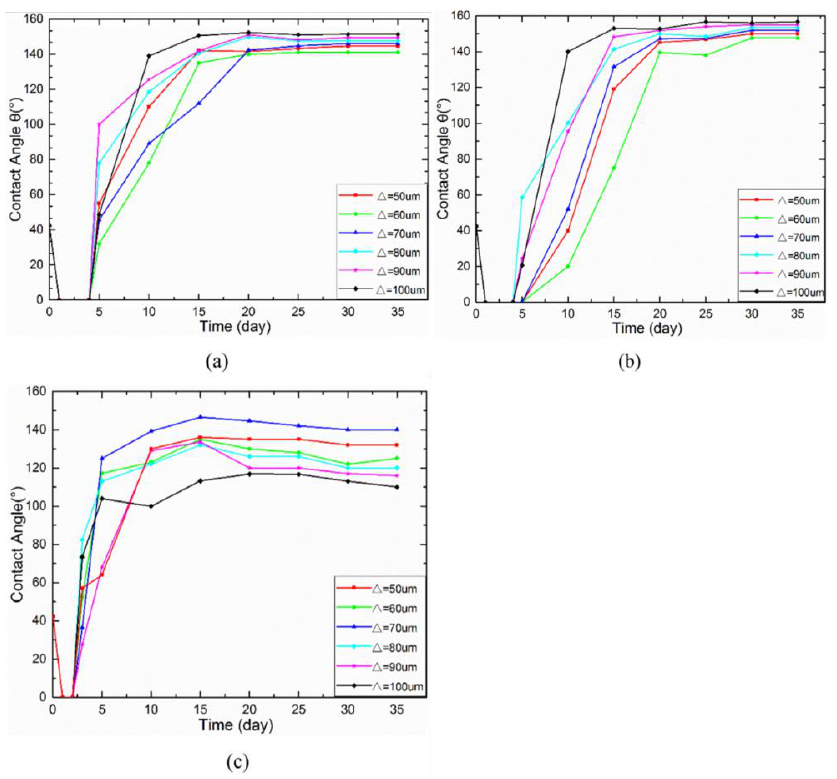
Figure 22. Evolution of the contact angle over time for: ( a ) line pattern, ( b ) grid pattern, and ( c ) spot pattern (Reprinted with permission from Ref. [64]. 2017, Yang, Z.).